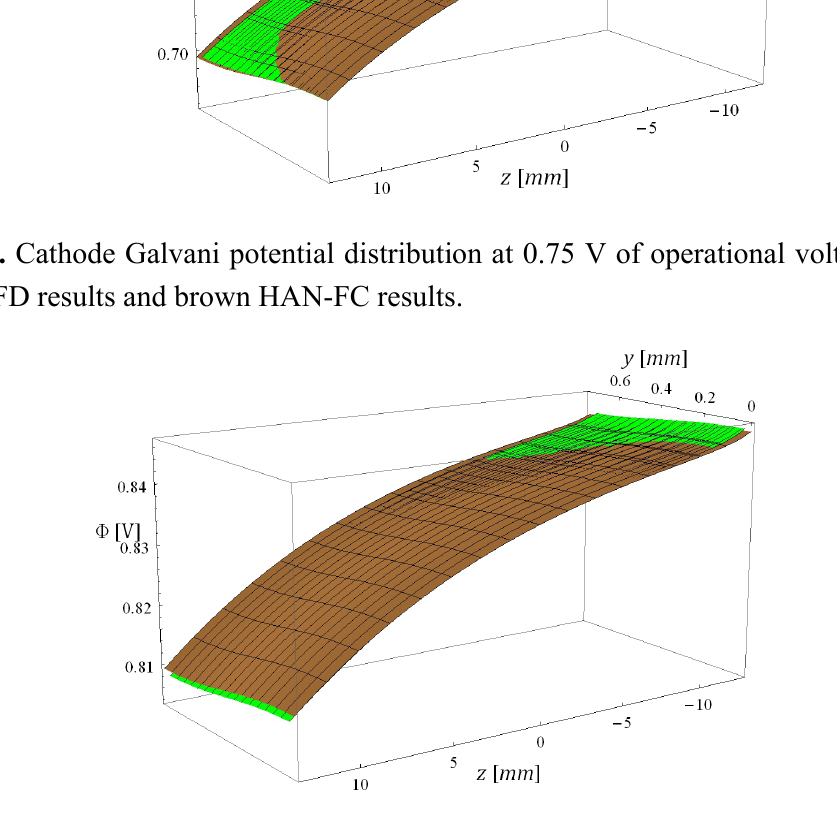
Figure 12. Water activity (relative humidity) on the central symmetry plane of a rib. Values in the membrane are obtained by interpolating values at the anode and cathode GDL/MEA